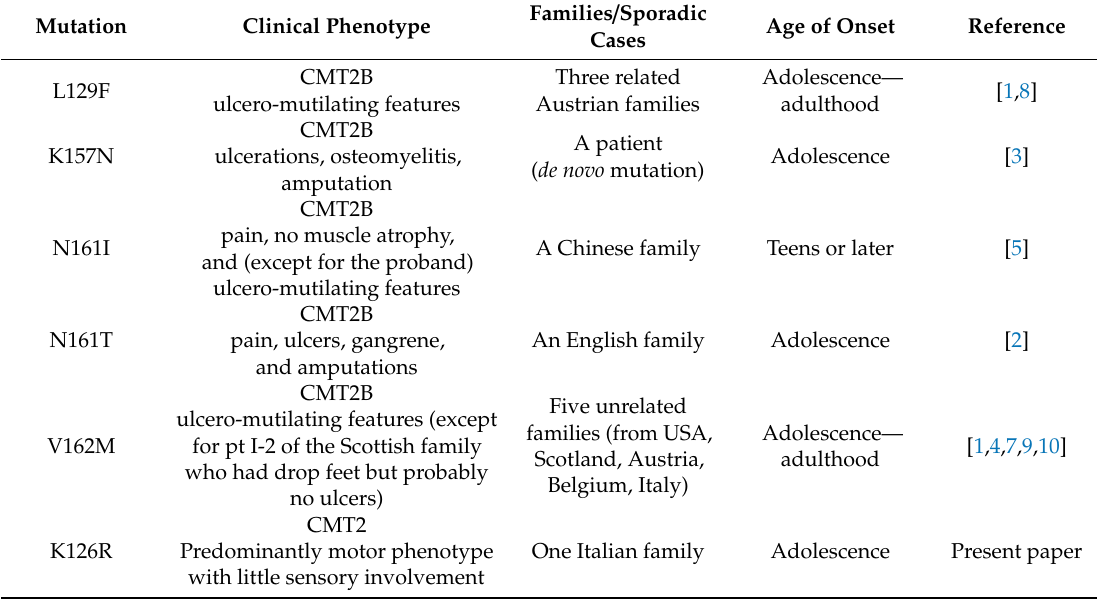
Table 1. RAB7A mutations associated with Charcot–Marie–Tooth type 2B